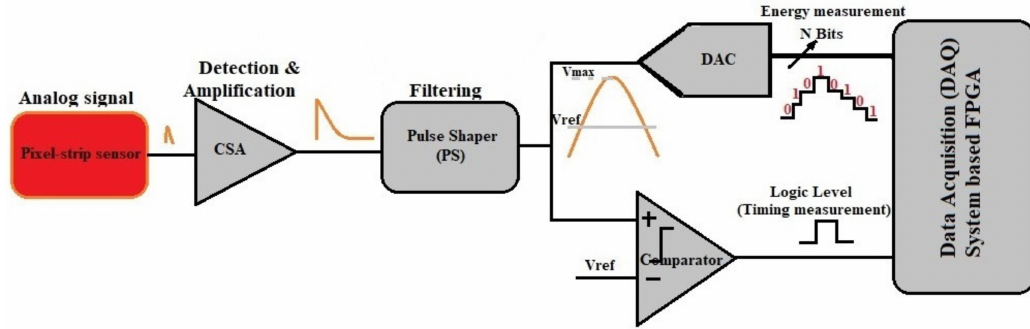
Figure 2. Pixel-strip sensor readout architecture for digital processing, the Charge Sensitive Amplifier (CSA) is used for extracting the charge at each strip and convert it into